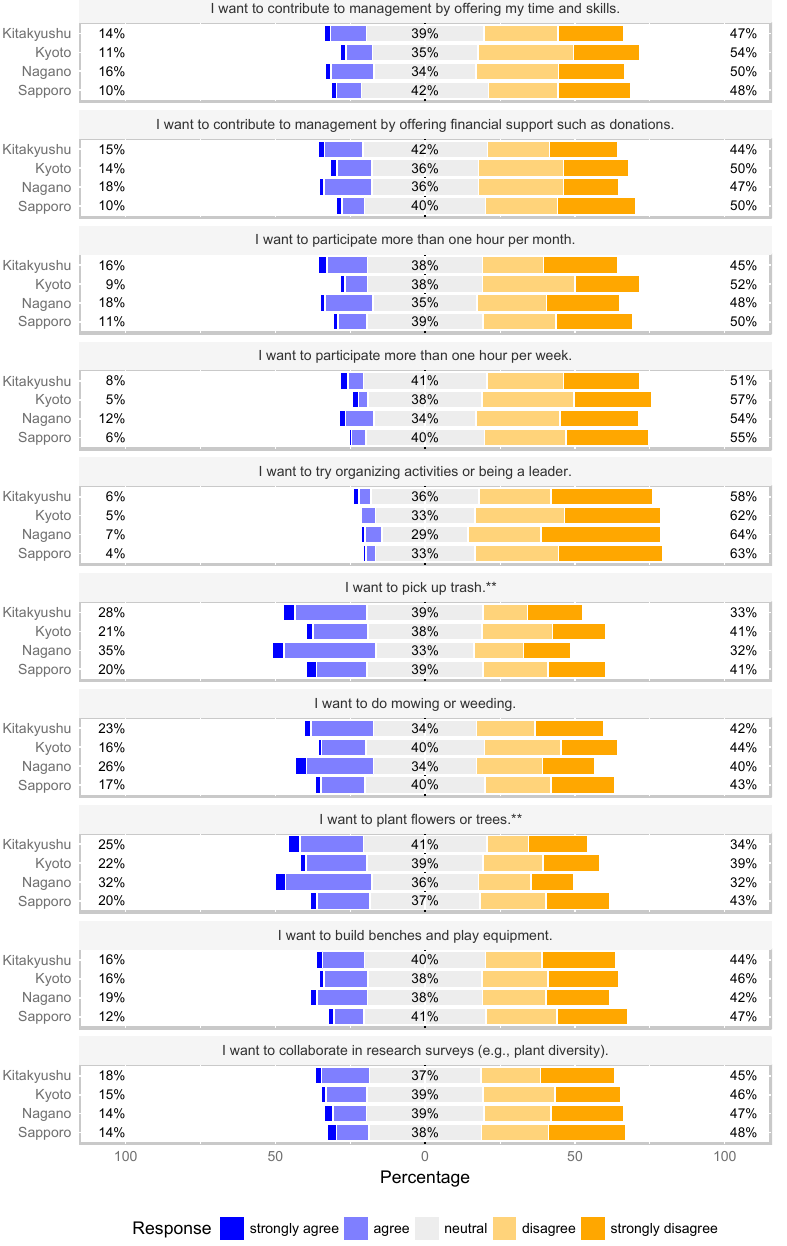
Figure 9. Respondents’ willingness to participate IGS management. Significant differences between the four cities are noted as ** ( p < 0.01).